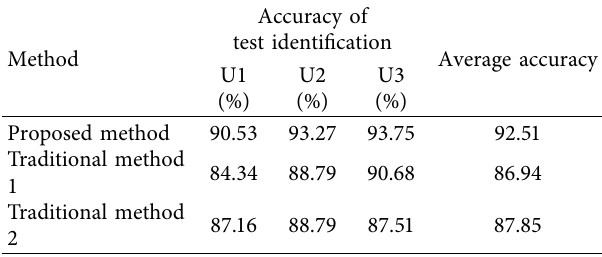
Figure 13: Comparison of training losses for the three Table 2: Comparison of single-string malfunction identification accuracy.